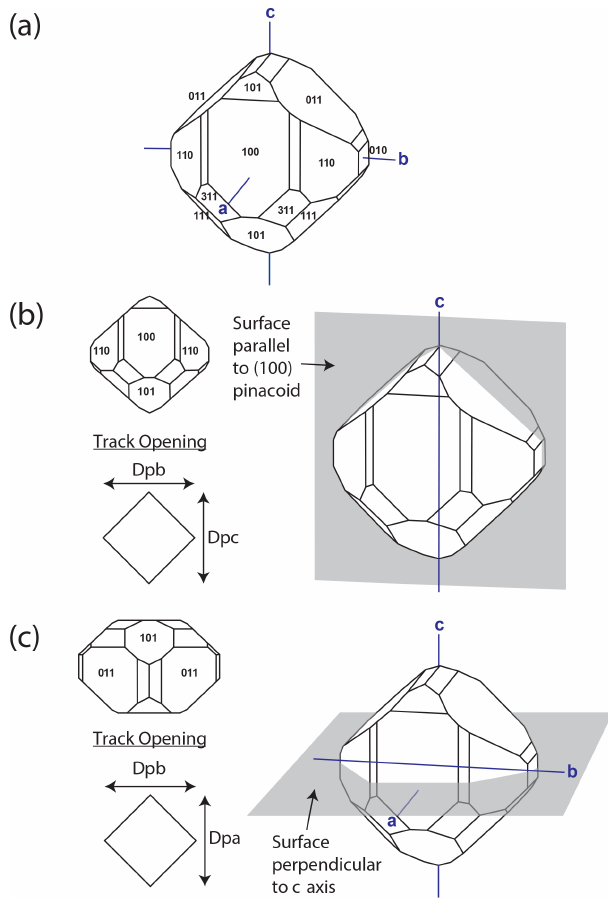
Figure 1. (a) Typical monazite crystal with Miller indices and crys- tallographic axes. (b) Crystal plane for tracks implanted on surfaces parallel to the (100) pinacoid face (i.e., parallel to the b and c axes). The shape of the track opening on the etched surface is a rhombus. Dpb represents diameter of etch pit parallel to b axis, and Dpc is de- fined as the diameter of etch pit parallel to c axis, equivalent to the parameters Dper and Dpar, respectively, in uniaxial minerals such as apatite. (c) Crystal plane for tracks implanted perpendicular to c axis. Track etch pits also tend to be diamond in shape. Dpa rep- resents diameter of track opening parallel to a axis. Models from https://Mindat.org (last access: 12 February